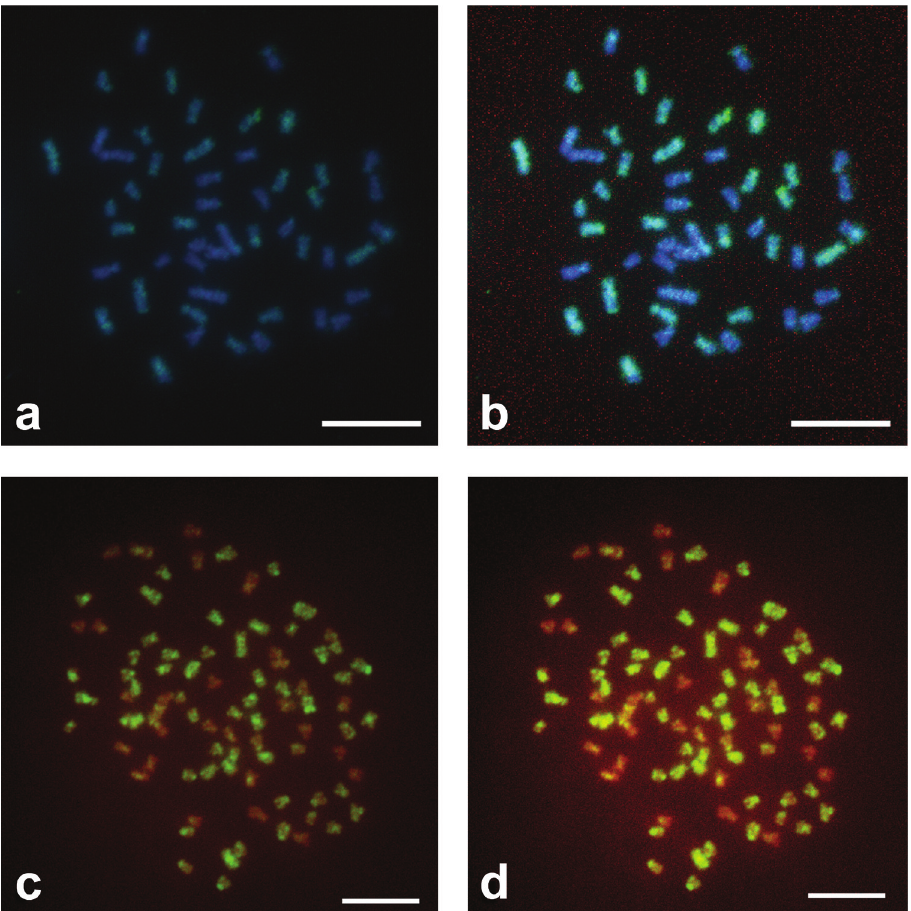
Figure 1. Standard use of GISH method in metaphase plates of specimens of S. alburnoides complex. a GISH with AA Dig labeled probe in PA metaphase plate revealed by anti-Dig FITC antibody counter- stained with DAPI - picture without photo editing b the same picture with photo editing c GISH with AA Dig labeled probe in PAA metaphase plate revealed by anti-Dig FITC antibody counterstained with PI, picture without photo editing d the same picture with photo editing. Scale Bars =